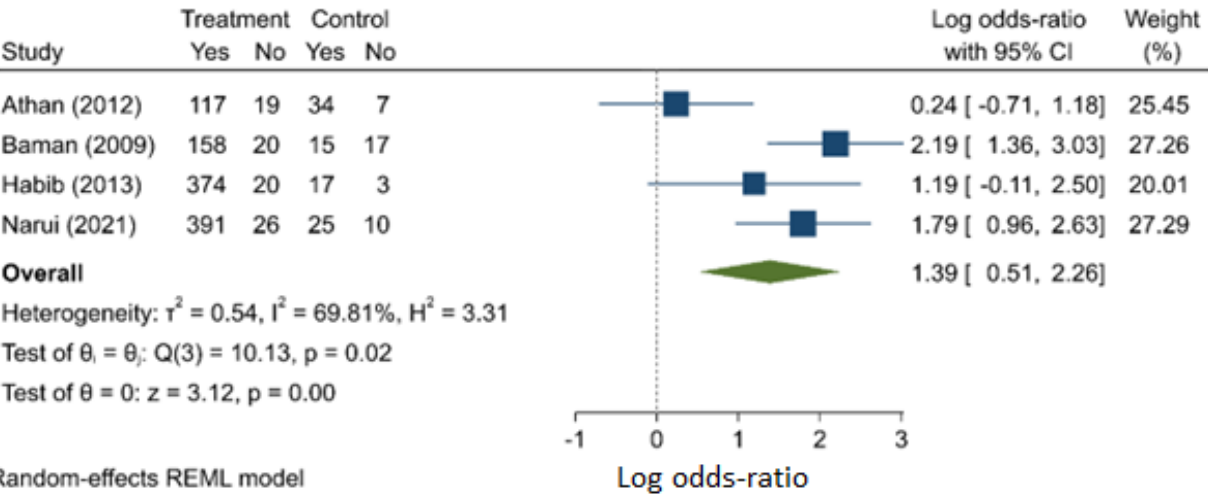
Figure 3. Presence of embolism/embolic phenomena as a risk factor for mortality.